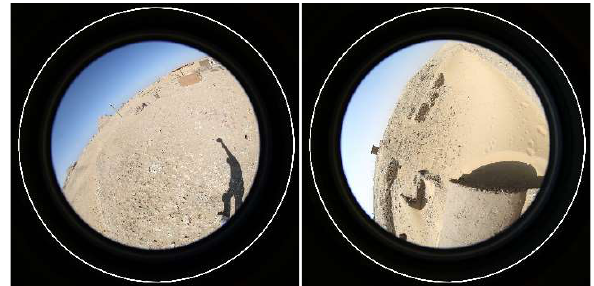
Figure 5. Images acquired during the survey by rotating the camera around the optical axis. The white rim around the images represents the full 180° image circle, masked by the lens cap.